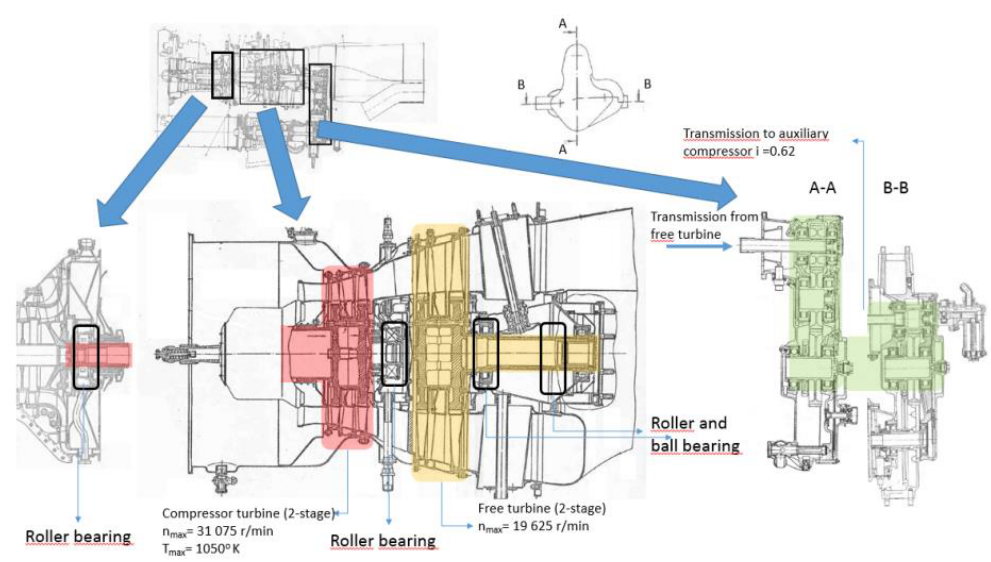
Figure 6. Cross-section of the VSU-10 engine (Adapted from [21]).